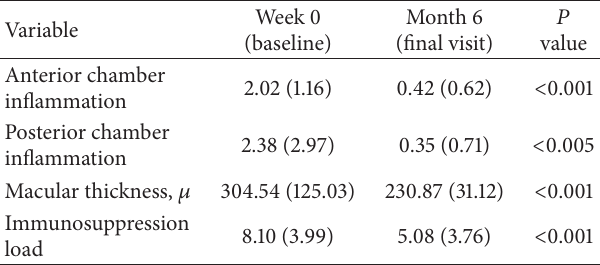
Table 1: Comparison of outcome variables before treatment with adalimumab and at the final visit.